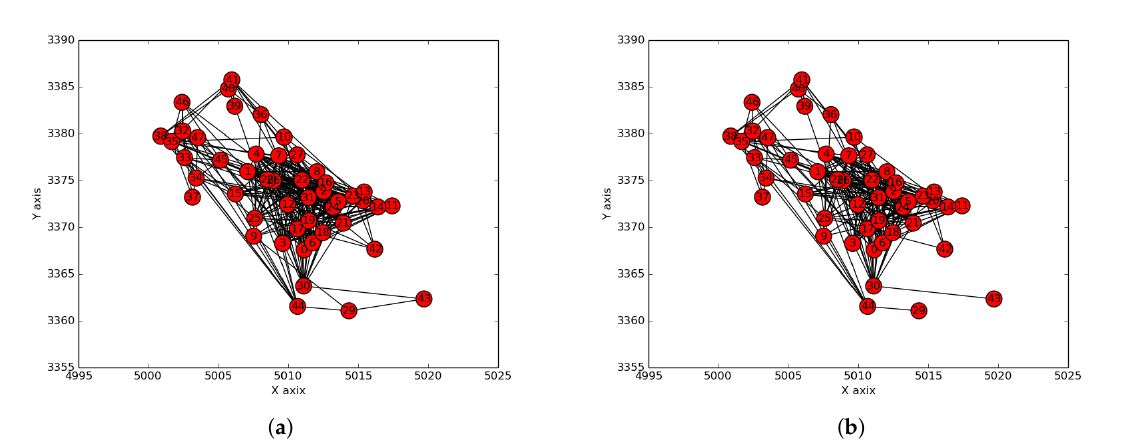
Figure 10. Processed networks. ( a ) Communication network considered; ( b ) UAV path network considered.